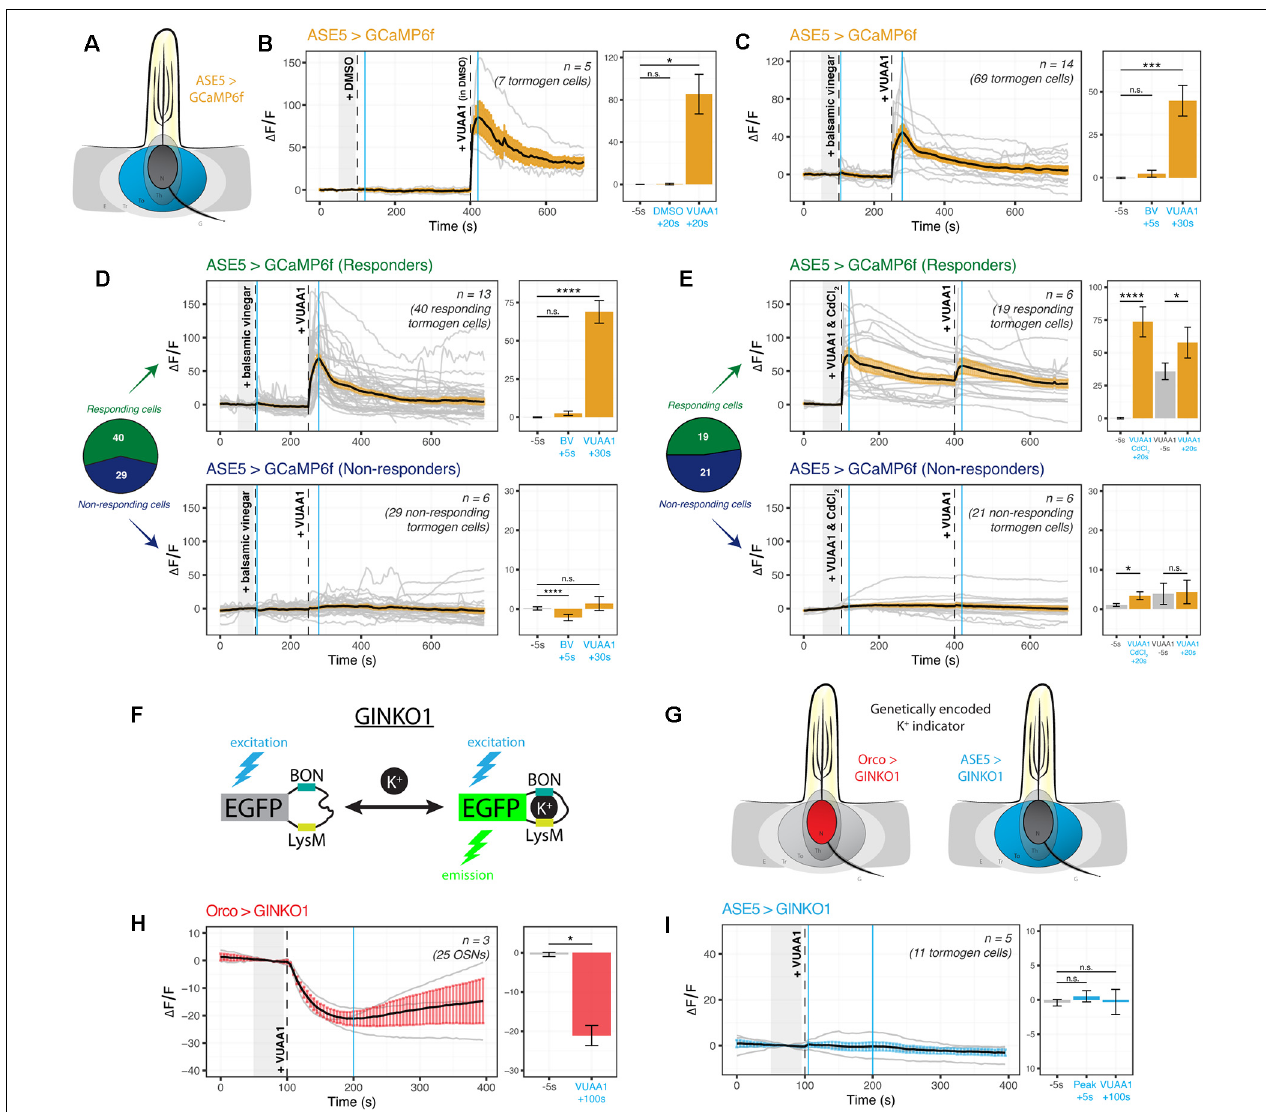
FIGURE 3 | Cation dynamics in tormogen cells during odorant presentation. Tormogen cells are targeted for cation imaging using ASE5-GAL4. (A) Paradigm for Ca 2+ imaging in tormogen cells. Ca 2+ reporters are expressed specifically in the tormogen cell type using the GAL4/UAS system in an ASE5-driven manner. (B) Tormogen cells respond with an acute influx of Ca 2+ following VUAA1 presentation. The effect is not attributable to intermediate solvent (DMSO) nor mechanical perturbations of liquid applied to the imaged antennal sample. (C) Response of tormogen cells to presentations of 1:1,000 balsamic vinegar and 100 µ M VUAA1. Tormogen cells show no response to balsamic vinegar at this concentration. (D) The plot of Ca 2+ imaging time course of individual cell responses (same experiment as shown in panel C ), subsetted by response or lack thereof. A subpopulation (42%) of ASE5-GAL4 driven cells does not respond to the odorant presentation. (E) The plot of CdCl 2 voltage-gated Ca 2+ -channel-blocking experiment. VUAA1 in both presence and absence of 100 µ M CdCl 2 elicits Ca 2+ influx into tormogen cells, but only in the responding subpopulation. Time courses and averages are plotted based on individual tormogen cell responses across all replicates.